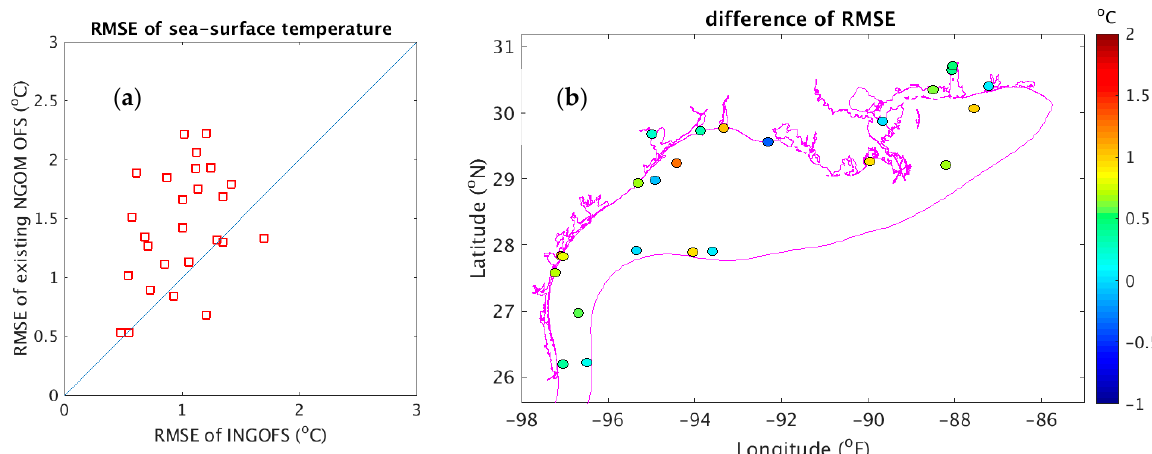
Figure 20. Comparison of the SST skill between the INGOFS and the NGOFS, ( a ) scatter plot of RMSE and ( b ) the RMSE difference between INGOFS and NGOFS.